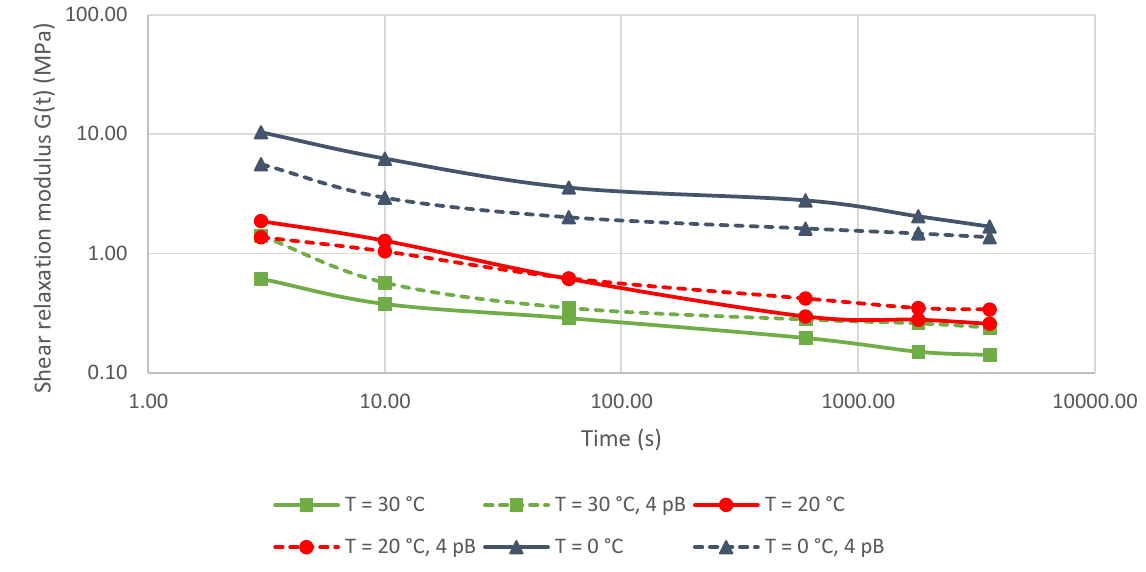
Fig. 6 Shear relaxation modulus for acoustic PVB for durations between 3s and 1 hour at different temperatures for the model of Table 2, and as derived from four point bending experiments (dotted lines, Kraus et al.